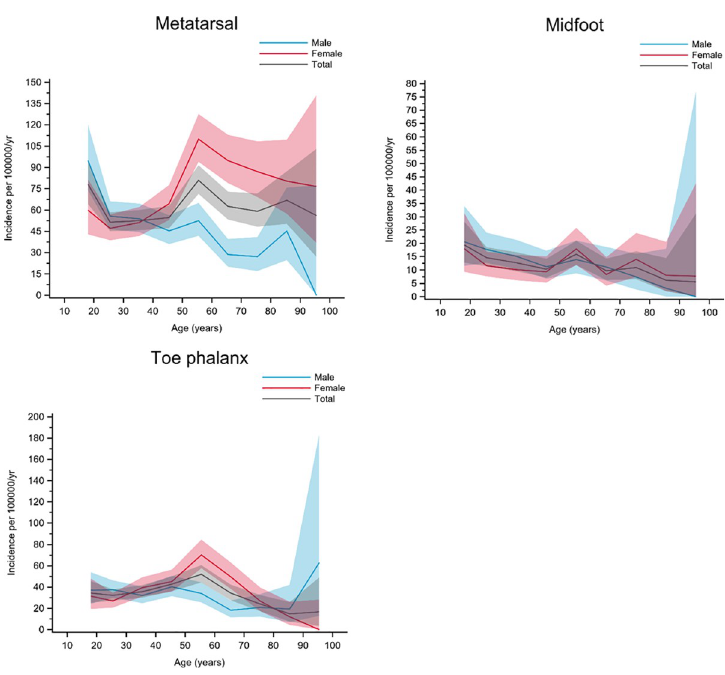
Fig 7. Fractures in group F. Age- and gender-specific incidence with 95% confidence interval. Black line represents the total population; red line represents females and blue line represents males.